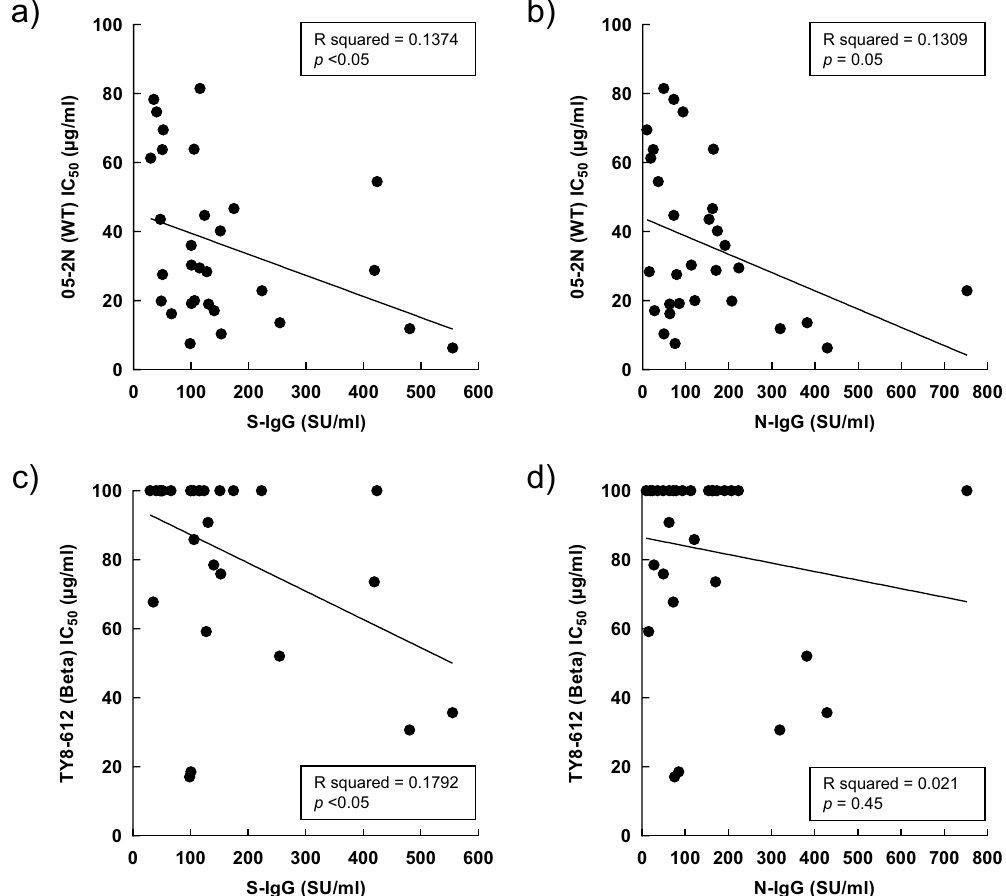
Figure 4. Correlation between neutralizing activity against antibody titers and wild-type and beta variant. ( a ) Wild-type vs. anti-S-IgG levels. ( b ) Beta variant vs. anti-S-IgG levels. ( c ) Wild-type vs. anti-N-IgG levels. ( d ) Beta variant vs. anti-N-IgG